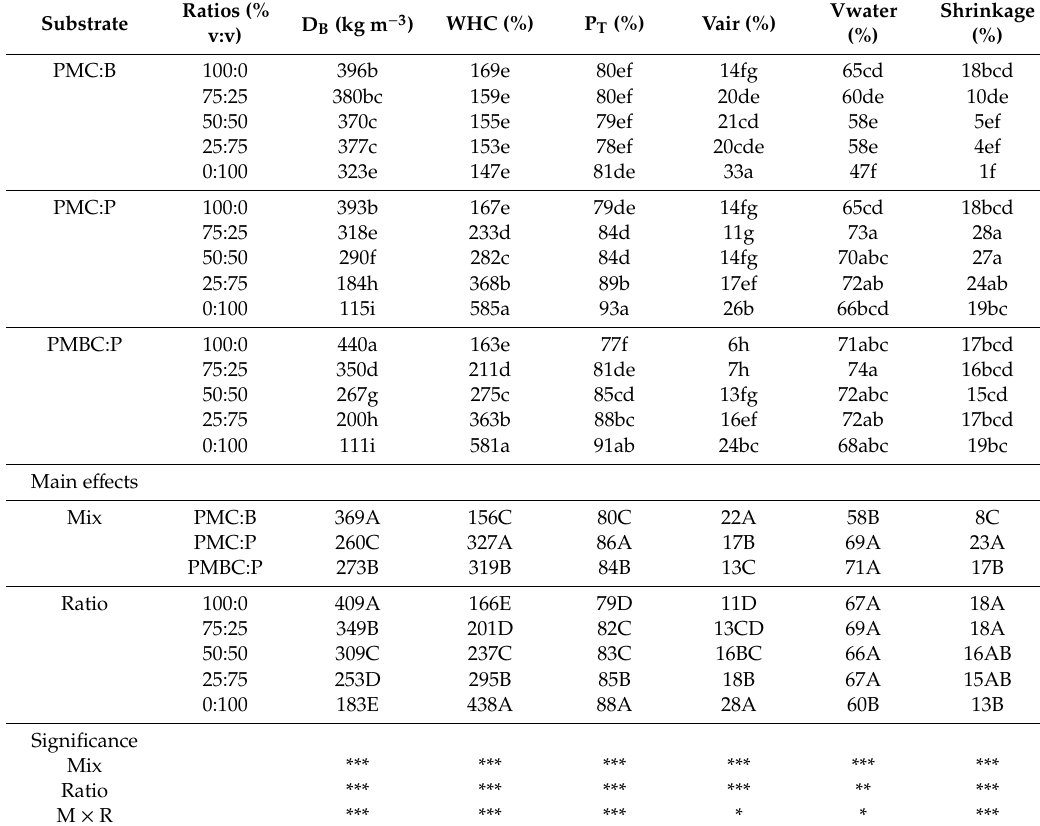
Table 2. Physical properties of growth media containing mixes of poultry manure composted without biochar (PMC), poultry manure composted with biochar (PMBC), biochar (B), and peat (P) at di ff erent ratios. Main e ff ects and statistical significance according to factorial analysis of variance. Three replicates ( n = 3) were used for each substrate and